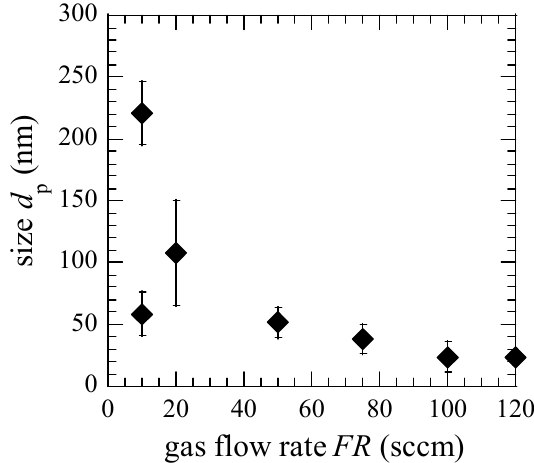
Figure 4. Dependence of d p on FR . Error bar shows the standard deviation.